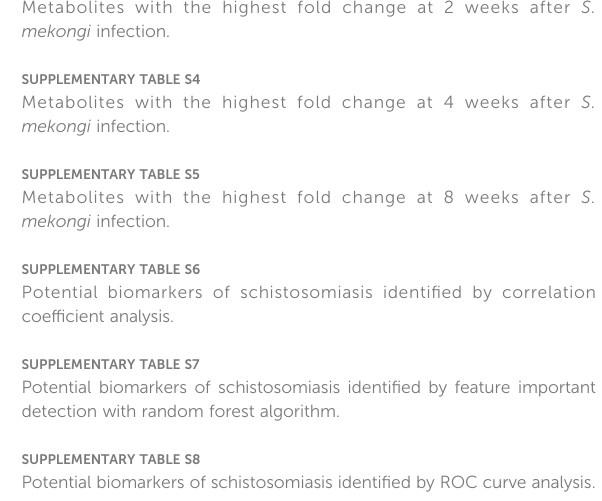
SUPPLEMENTARY TABLE S3 Metabolites with the highest fold change at 2 weeks after S. mekongi infection. SUPPLEMENTARY TABLE S4 Metabolites with the highest fold change at 4 weeks after S. mekongi infection. SUPPLEMENTARY TABLE S5 Metabolites with the highest fold change at 8 weeks after S. mekongi